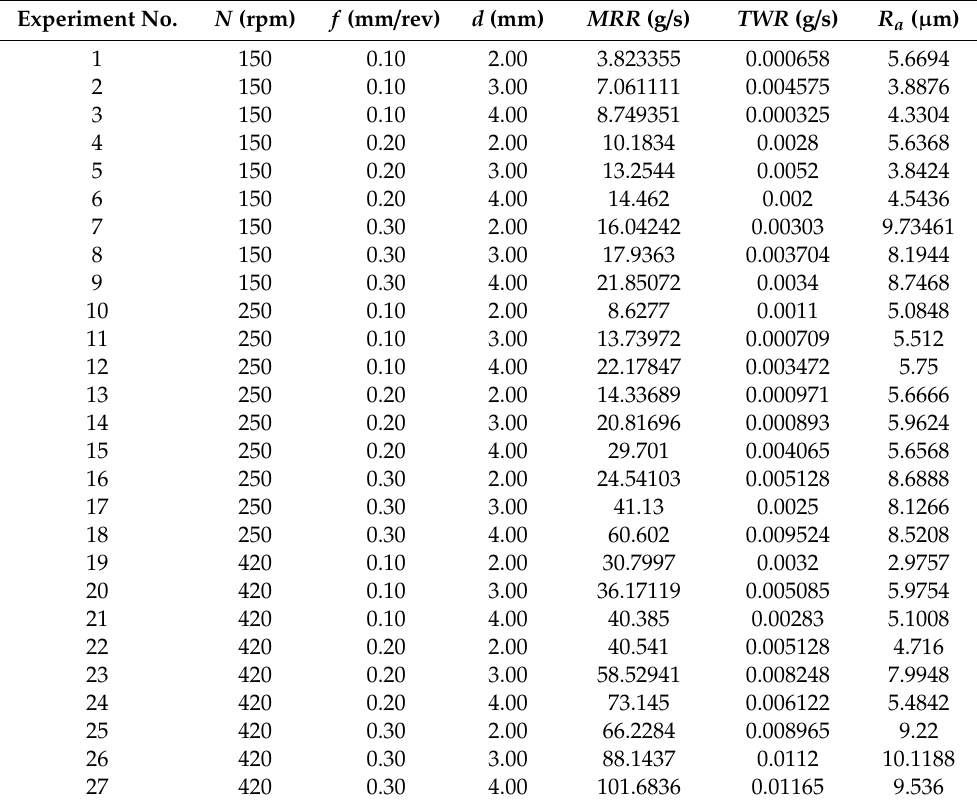
Table 5. Experimental results for turning of GFRP